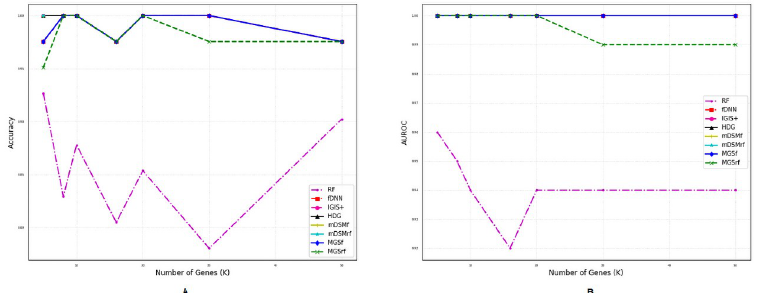
Fig 4. Performance comparison using different number of selected genes for the GDS3341 dataset. (A) Accuracy. (B) AUROC.